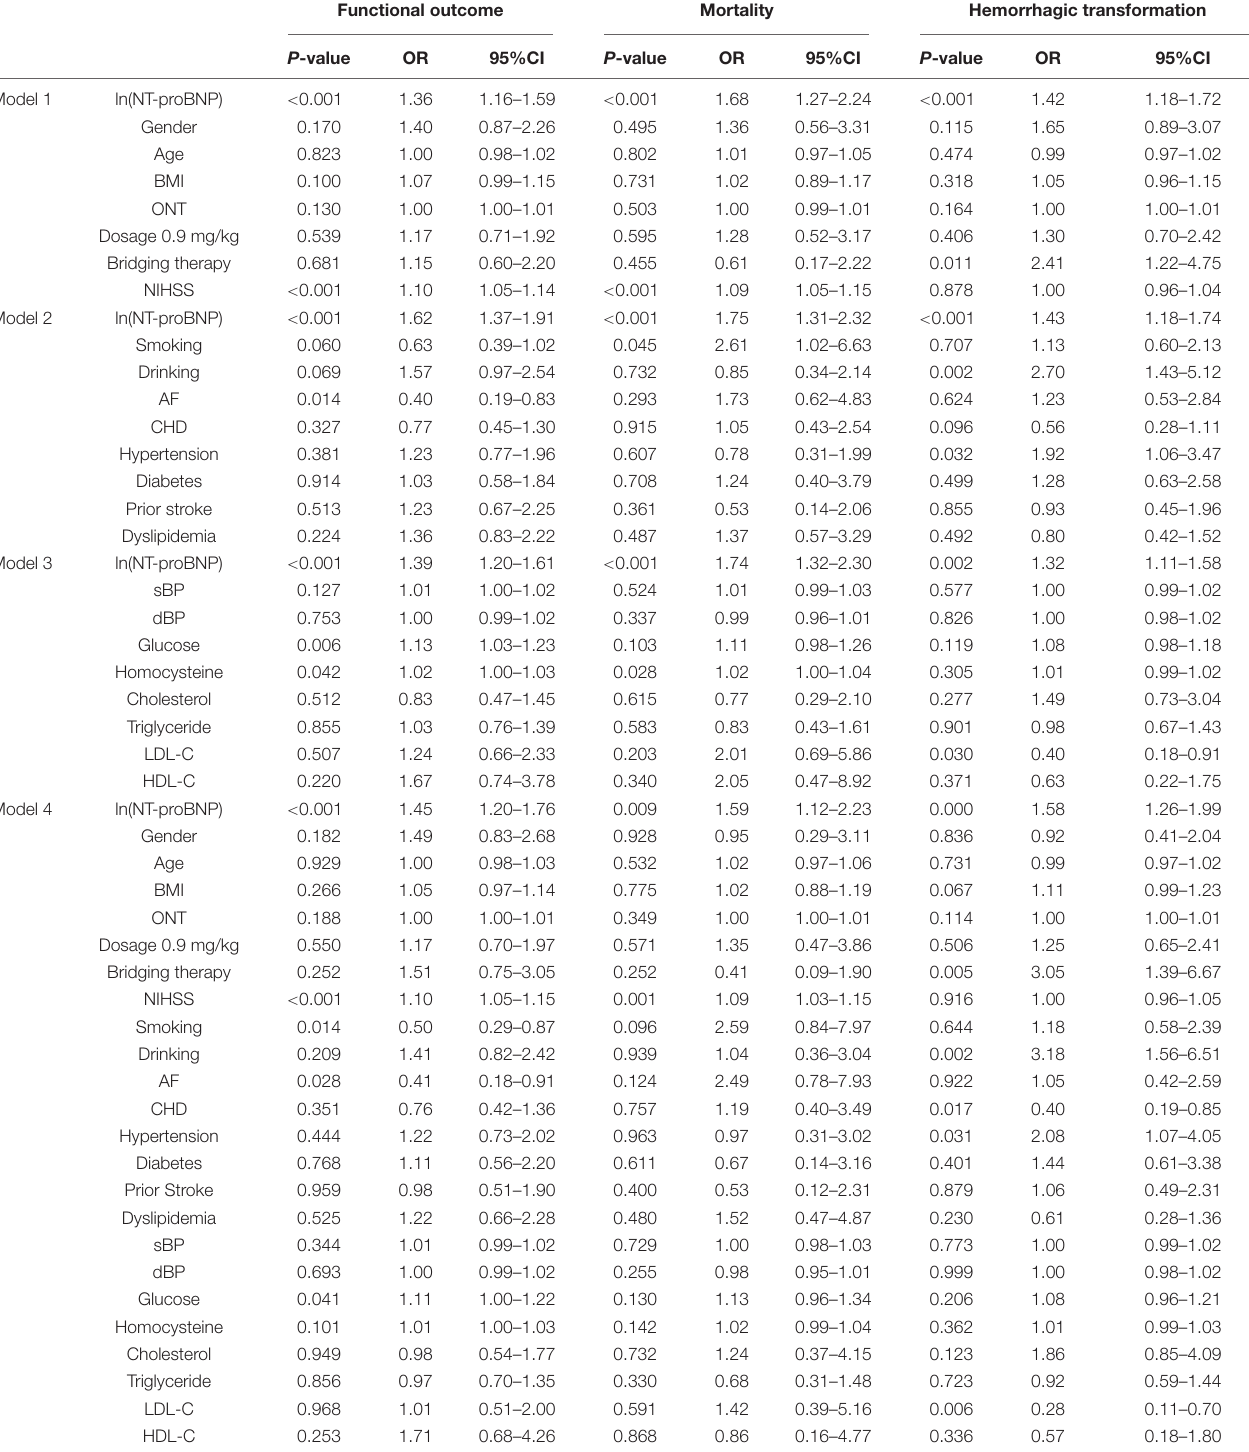
TABLE 5 | Results of multivariate